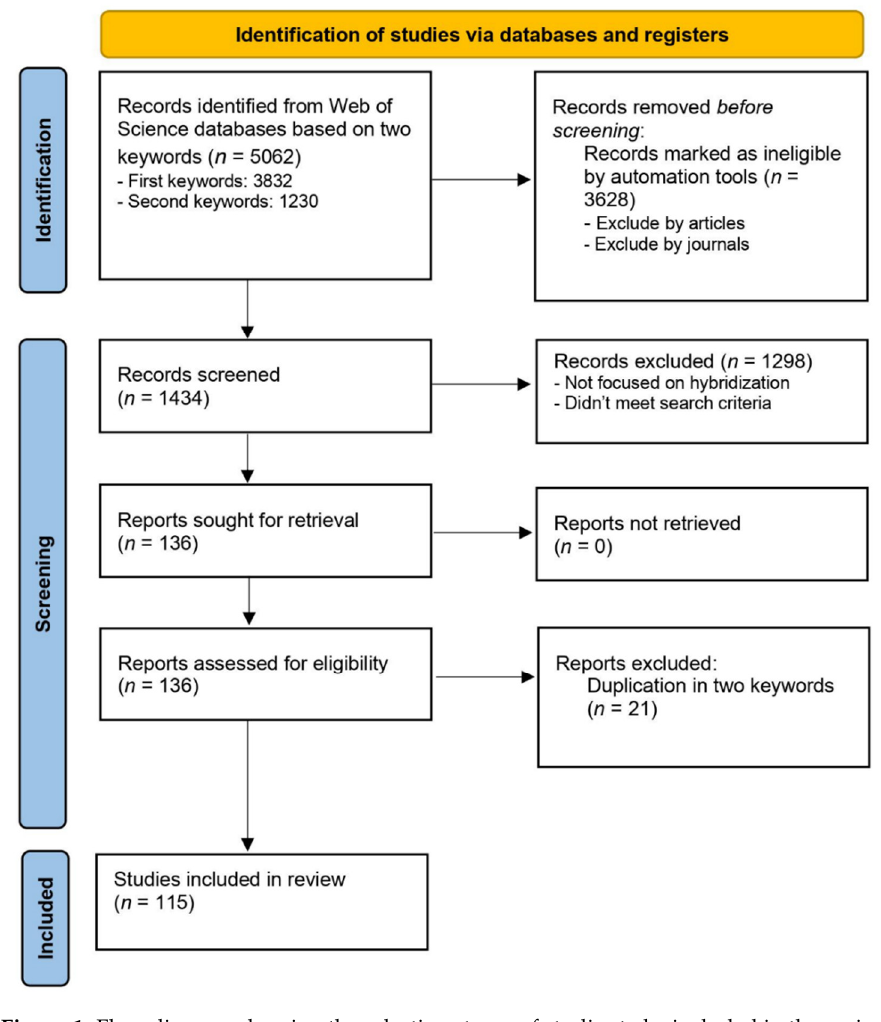
Figure 1. Flow diagram showing the selection stages of studies to be included in the review based on the two sets of keywords used.